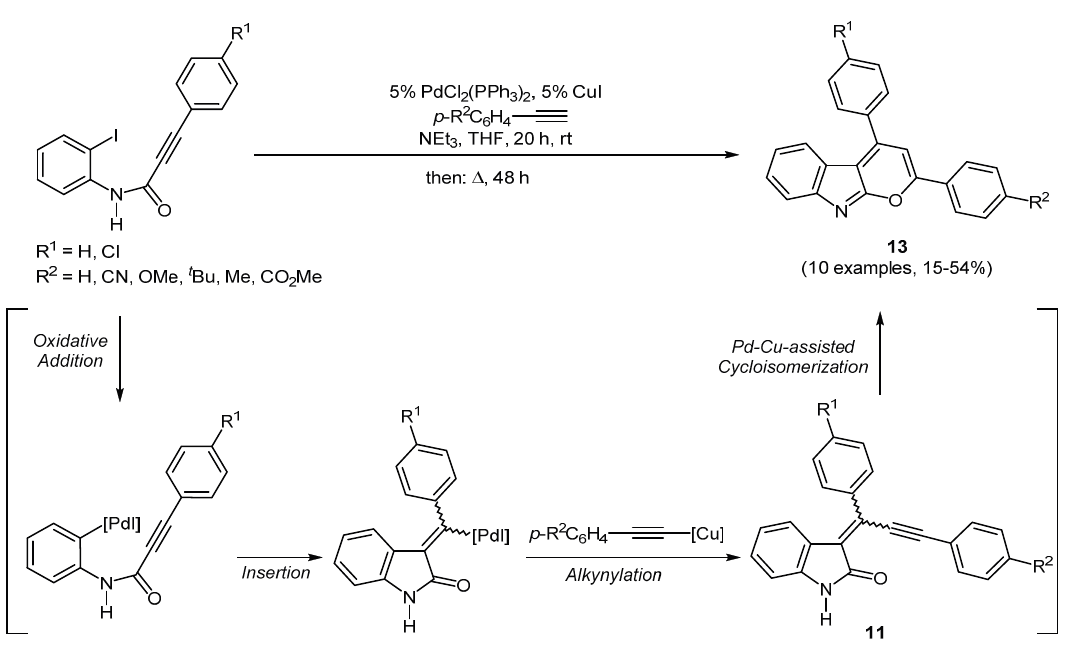
Scheme 6. Sequentially Pd-Cu-catalyzed insertion-coupling-cycloisomerization domino synthesis of 2,4-diarylpyrano[2,3- b ]indoles 13